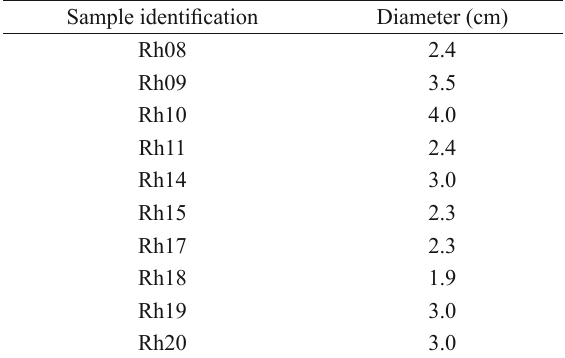
Diameters (measured at the base) of each sampled